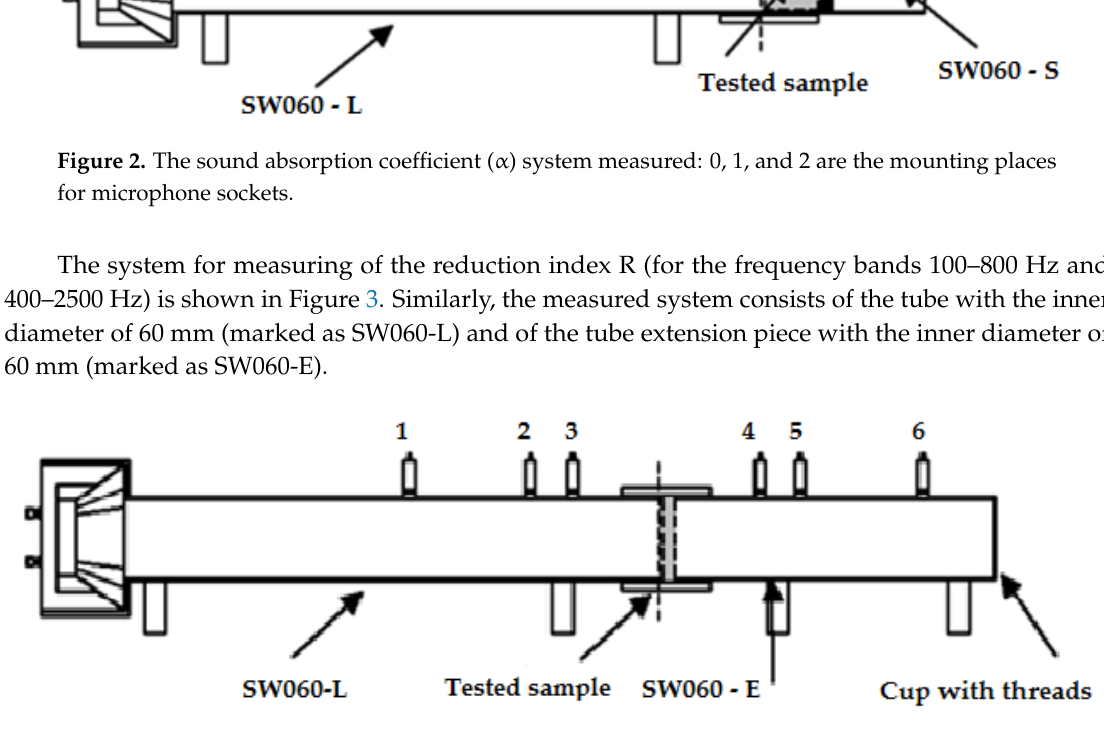
Figure 3. The reduction index R system measured: 0, 1, 2, 3, 4, and 5 are the mounting places for microphone sockets.